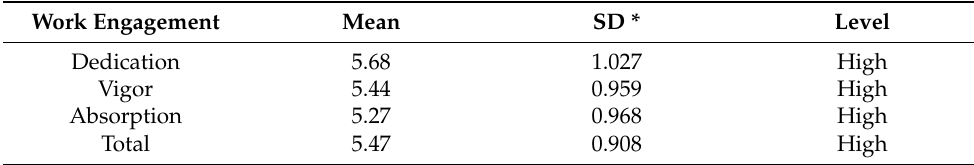
Table 2. Nurses’ Level of Work Engagement.